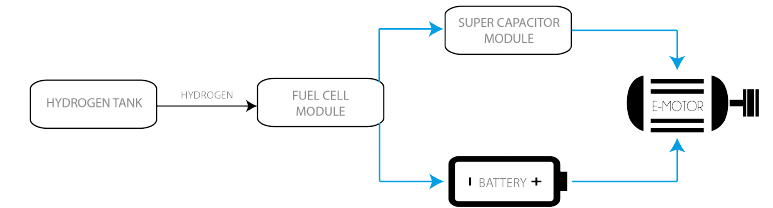
Figure 5. A diagram of the configuration of